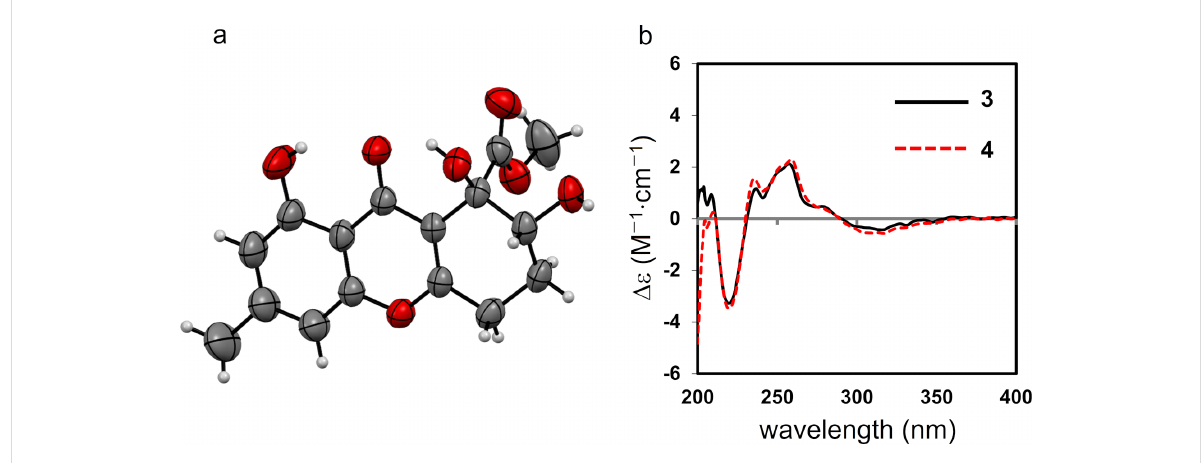
Figure 4: a) ORTEP drawing of 3 , with thermal ellipsoids indicating 50% probability. b) Electronic circular dichroism spectra of 3 (black solid line) and 4 (red dashed line).